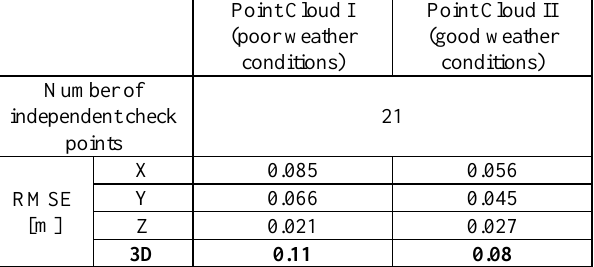
Table 4. Point clouds absolute accuracy